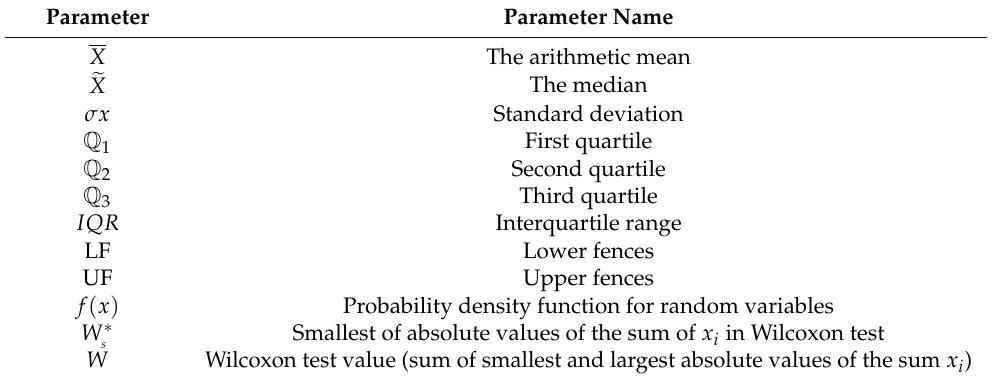
Table 6. Parameters List for DHNN − δ 2 SAT